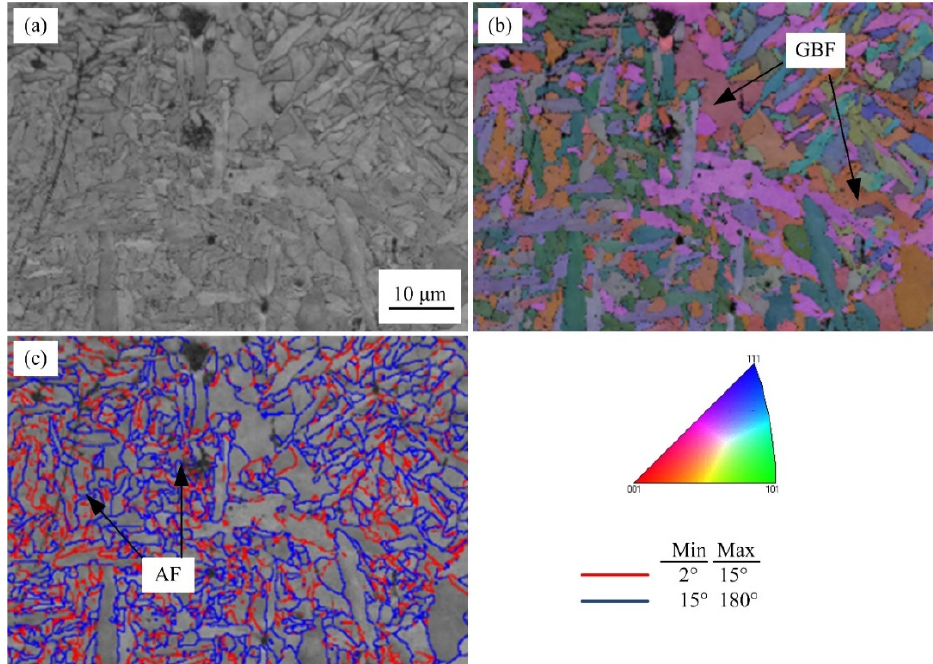
Figure 11. EBSD maps of weld metals at the cooling rate of 10 °C/s. ( a ) Image quality maps, ( b ) inverse pole figure maps, and ( c ) grain boundaries of misorientation angle >15° (blue) and 2–15° (red).